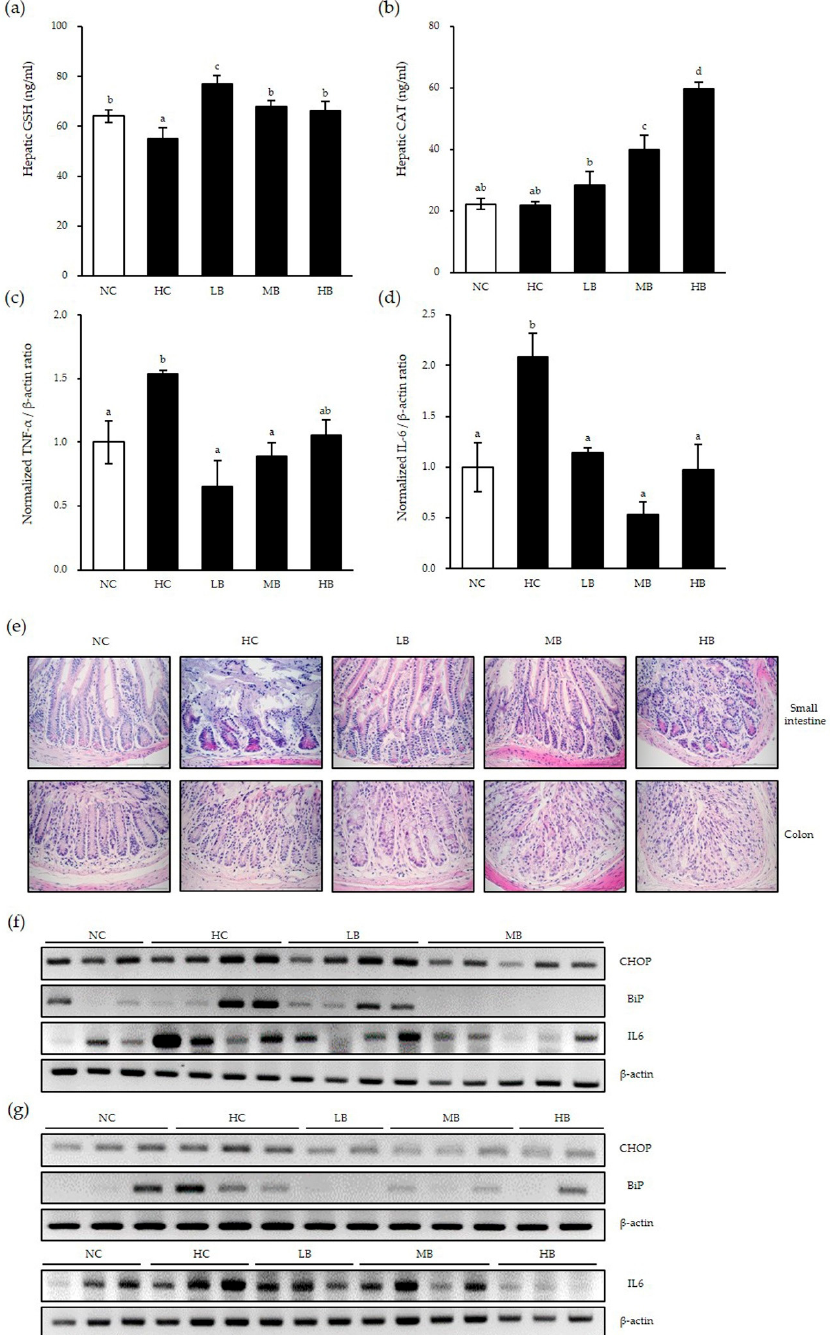
Figure 5. Antioxidant and anti-inflammatory effects of BG in nonalcoholic fatty liver disease (NAFLD)-induced mice. Liver tissue was harvested and examined using ELISA ( a,b ) and real-time qPCR ( c , d ). The small intestine and colon were harvested and stained with hematoxylin and eosin (H&E) ( e ). Whole tissues of small intestine ( f ) and colon ( g ) were harvested and total RNA was extracted for RT-PCR. β -actin was used as the loading control. Data are shown as the means ± SD of three independent experiments. Significant differences between different concentrations were analyzed using Duncan’s multiple range test with one-way ANOVA and values labeled with different letters are significantly different ( p < 0.05). GSH, glutathione; CAT, catalase; NC, normal untreated control; HC, high-fat/high-fructose diet; LB, HC + 0.5% black ginseng; MB, HC + 1% black ginseng; HB, HC + 2% black ginseng. The mRNA expression level was normalized to β -actin and expressed relative to the NC control group, which was set to